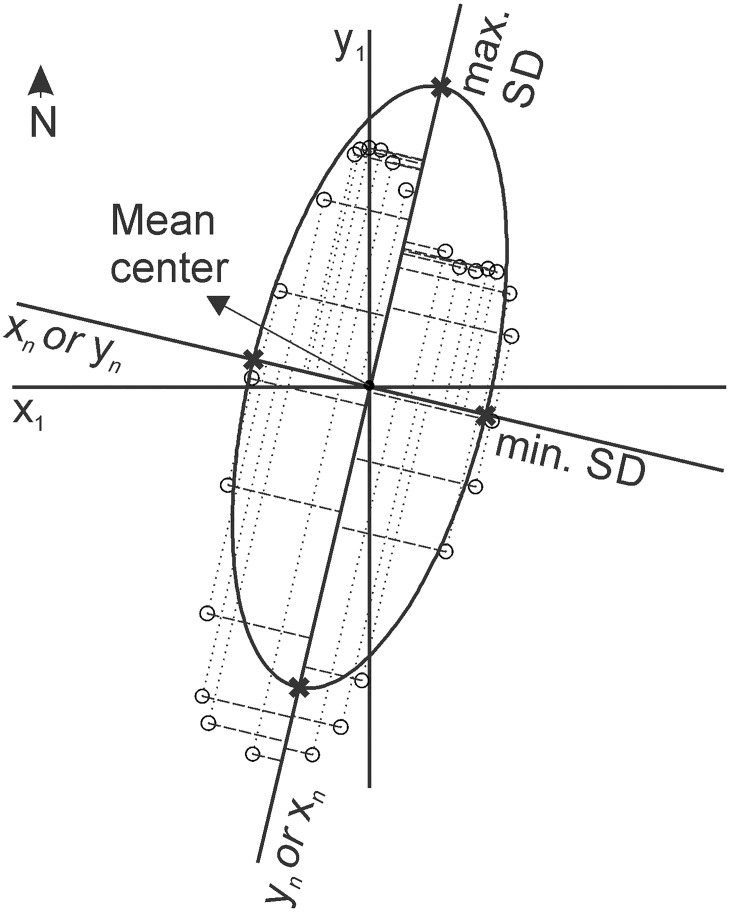
Computation of the standard deviational ellipse.Two orthogonal coordinate systems centered on the mean center of the dataset are represented. The small circles are the vertices of a longitudinal subglacial bedform footprint. The ellipse’s long axis is a segment of the axis for which the standard deviation (SD in diagram) of the distances from the vertices to the axis (dashed lines) is smallest relative to any other axis orientation. The ellipse’s minor axis corresponds to a segment of the axis that yields maximum standard deviation. The two axes are always orthogonal to each other.